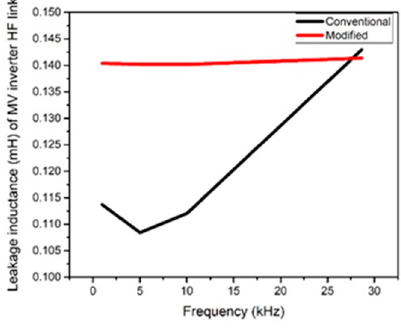
Figure 15. Toroidal transformers at 360° sectored winding, leakage inductance comparison of modified and conventional design of high-frequency link-based MV inverter systems.